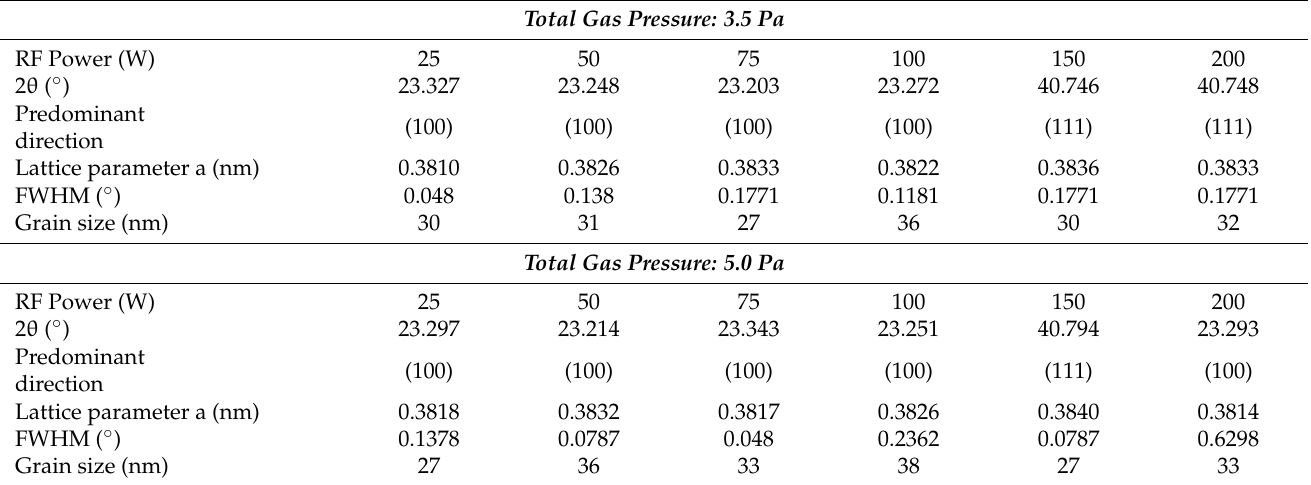
Table 2. Main XRD data extracted from the XRD spectra of the Cu 3 N films fabricated on glass by reactive RF magnetron sputtering in pure N 2